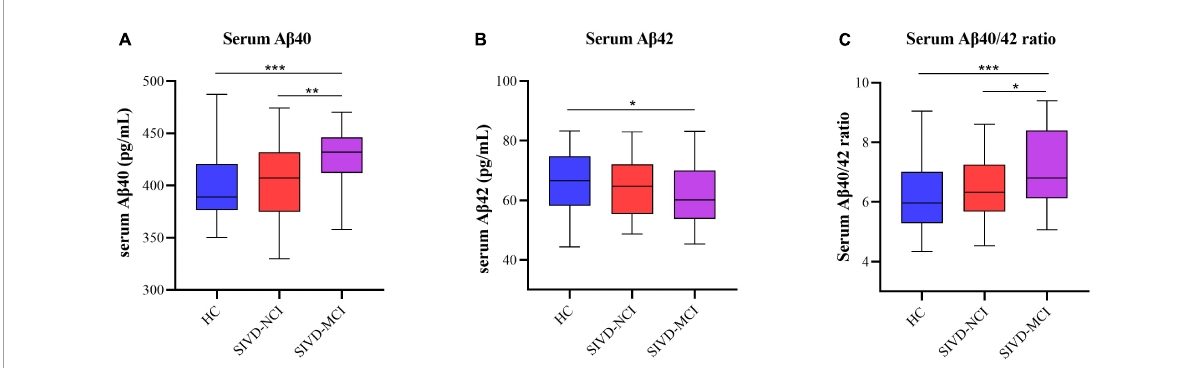
FIGURE1 Boxplots of differences in serum A β 40, A β 42, and A β 40/42 levels between HC, SIVD-NCI, and SIVD-MCI groups. (A) Comparison of serum A β 40 levels among the three groups of HC, SIVD-NCI and SIVD-MCI. (B) Comparison of serum A β 42 levels among the three groups of HC, SIVD-NCI and SIVD-MCI. (C) Comparison of serum A β 40/42 levels among the three groups of HC, SIVD-NCI and SIVD-MCI. HC, healthy control; SIVD, subcortical ischemic vascular disease; NCI, no cognitive impairmen; MCI, mild cognitive impairment; * P < 0.05; ** P < 0.01; *** P < 0.001.